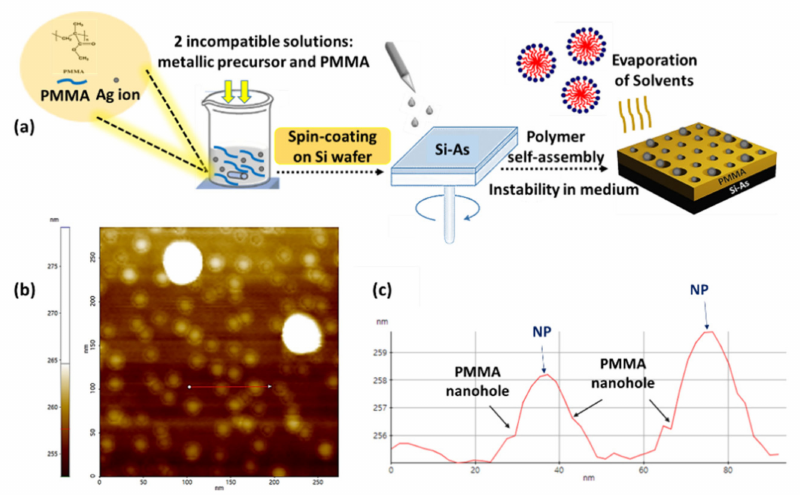
Figure 1. ( a ) Schematic representation of the VIPS approach, showing the growth of two different di- ameters of AgNPs into PMMA nanoholes attached with ( b ) an AFM image, and ( c ) its corresponding line -scan